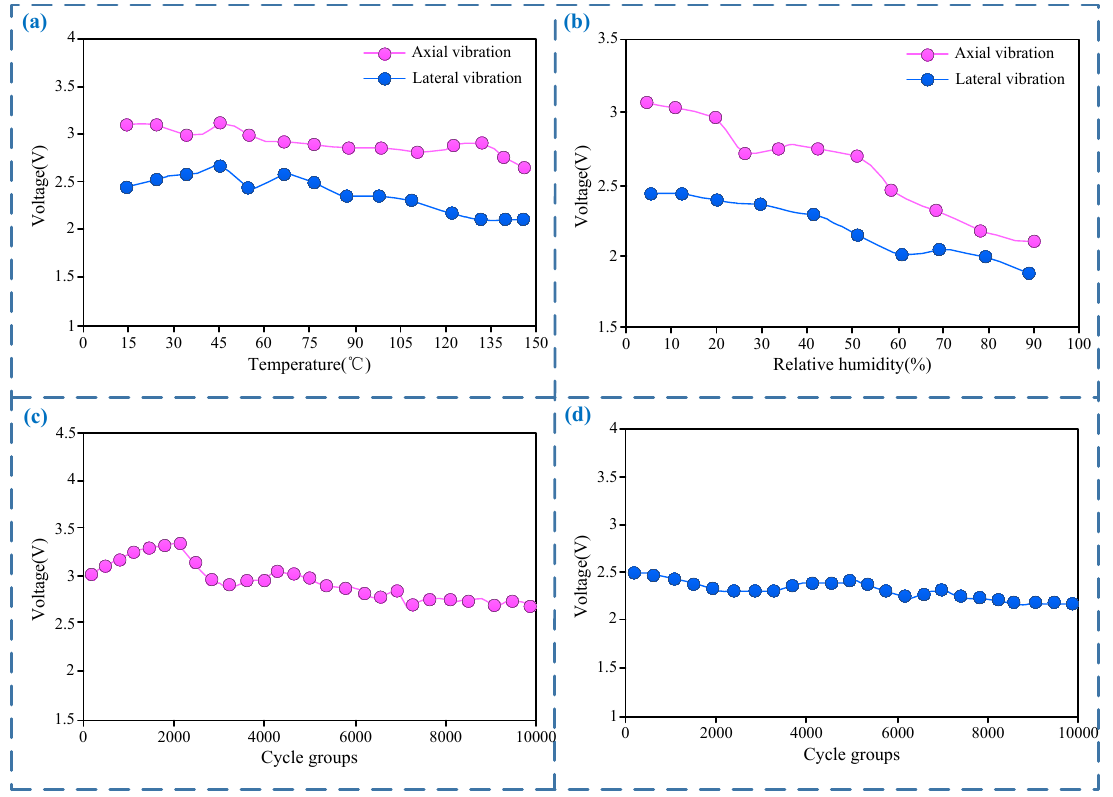
Figure 6. Results of environmental tests. ( a ) Output voltage of the axial and lateral vibration at different temperatures; ( b ) output voltage of the axial and lateral vibration at different relative humidity; ( c ) output voltage of the axial vibration in different cycle groups; and ( d ) output voltage of the lateral vibration in different cycle groups.